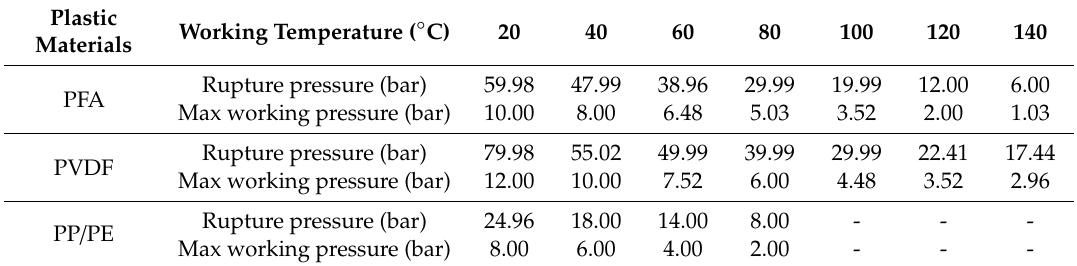
Table 1. Operating temperatures and pressures for di ff erent polymer